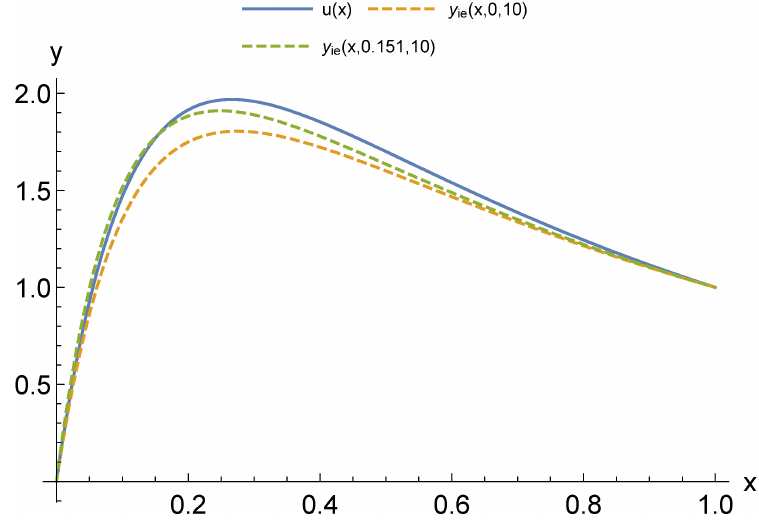
Figure 13. Plots of multilayer solutions y ie ( x ,0,10 ) , y ie ( x ,0.151,10 ) (42) based on the implicit Euler method (number of layers n = 10) as applied to problem (30) and its exact solution u ( x ) (parameter value s = 0.1), corresponding to dashed lines and solid line, respectively.